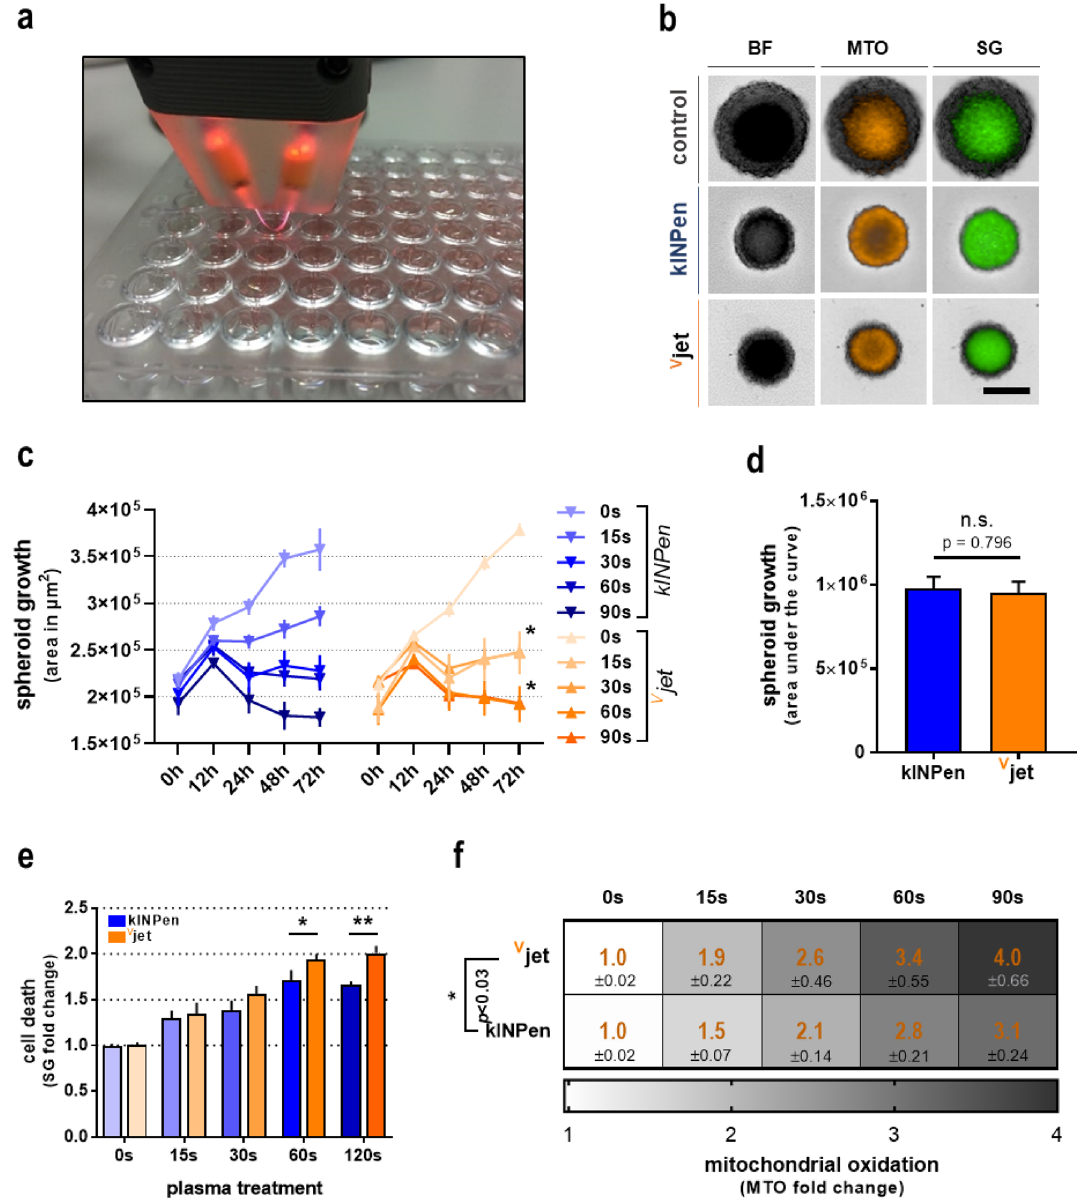
Figure 2. Cytotoxicity in 3D tumor spheroids following plasma treatment. ( a ) Image of the V jet treatment of 3D multicellular tumor spheroids derived from CT26 colon carcinoma cells; ( b ) representative images of tumor spheroids in brightfield (BF), mitotracker orange (MTO), and sytox green (SG) fluorescence channel 24 h after plasma treatment; ( c ) spheroid growth over 72 h after plasma treatment; ( d ) cell death and ( e ) mitochondrial oxidation 24 h after plasma treatment. Data are representative of three independent experiments. Statistical analysis was performed using two-way Anova or t- test (*p < 0.05); **p < 0.01); n.s. = non-significant. scale bar = 200